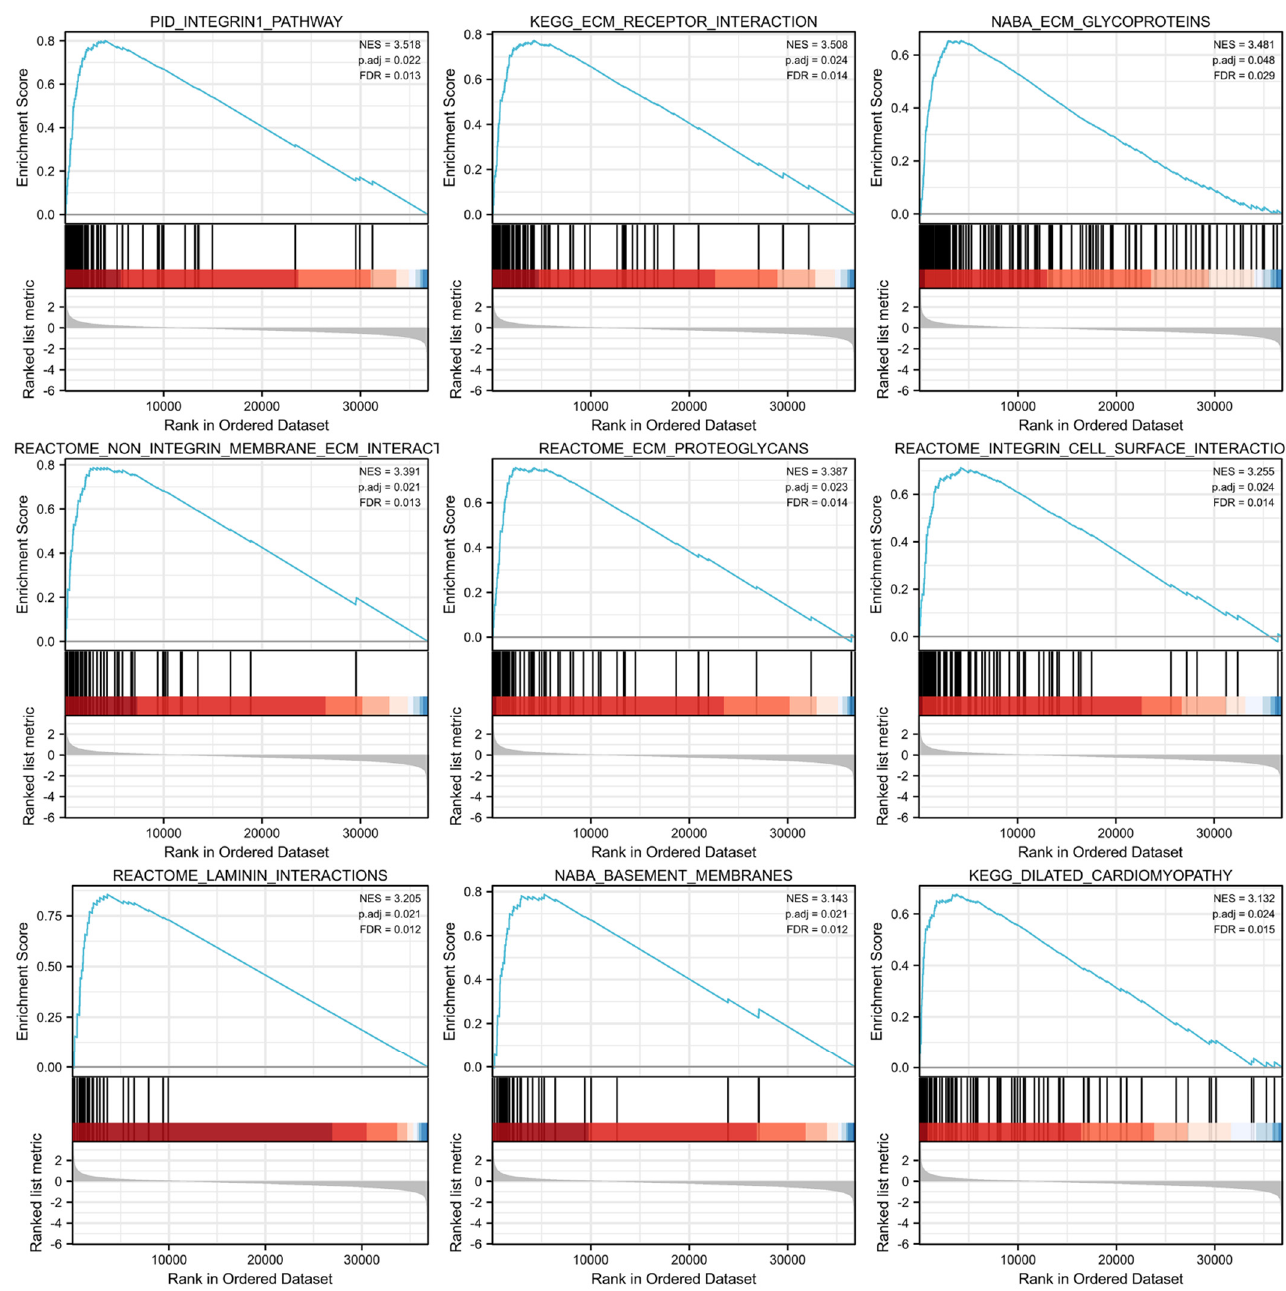
Figure 5. GSEA analysis of SEC23A in